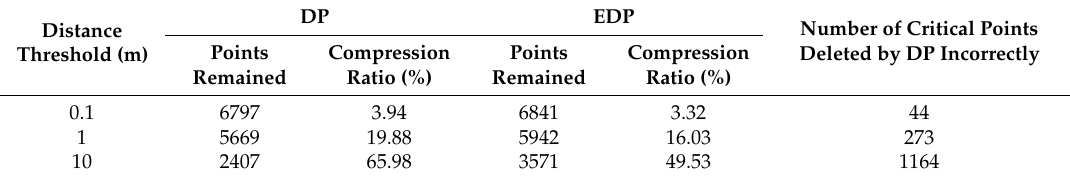
Table A2. Speed loss of DP and EDP simplification with different distance thresholds.